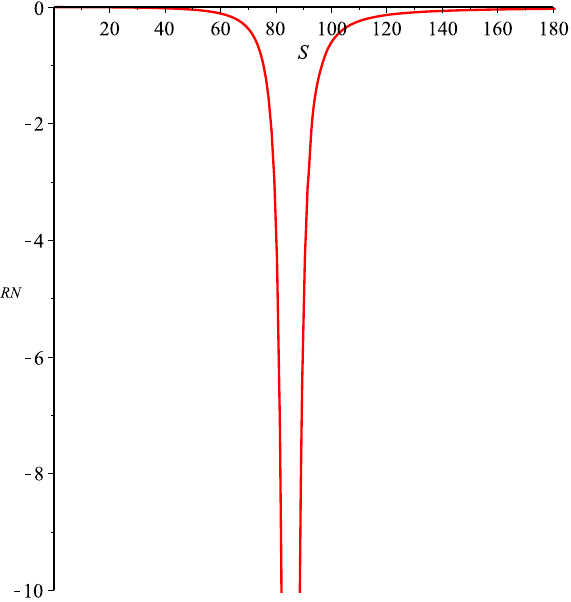
Fig. 1 The curvature scalar R RN as a function of the entropy S with Q = 10 and d =